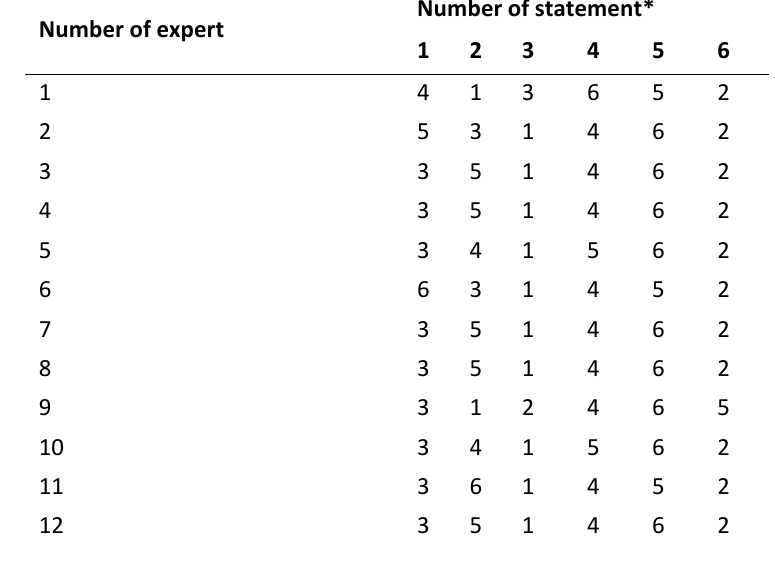
Table 1. Results of experts’ assessment of significance of systemized reasons of negative tendencies in children’s